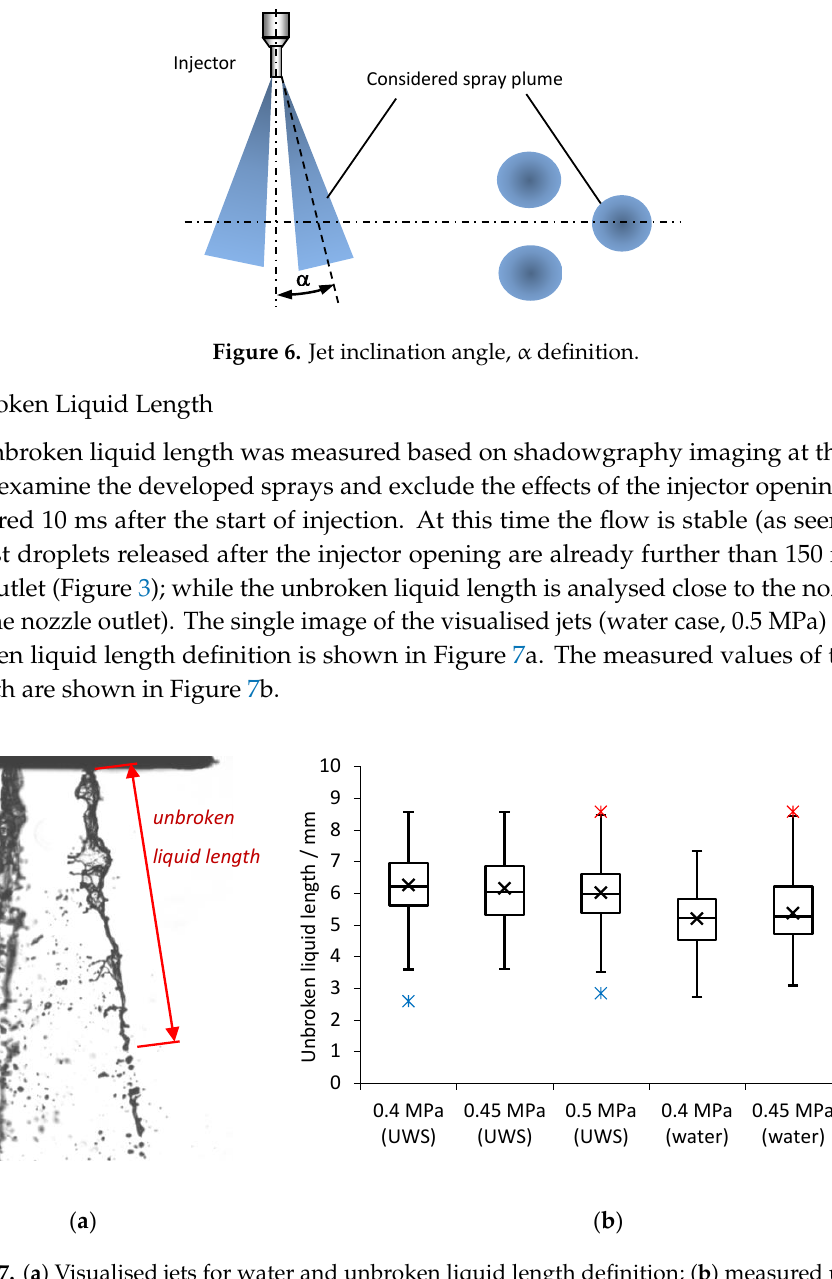
Figure 7. ( a ) Visualised jets for water and unbroken liquid length definition; ( b ) measured unbroken liquid length (for 99 injections for each injection pressure).